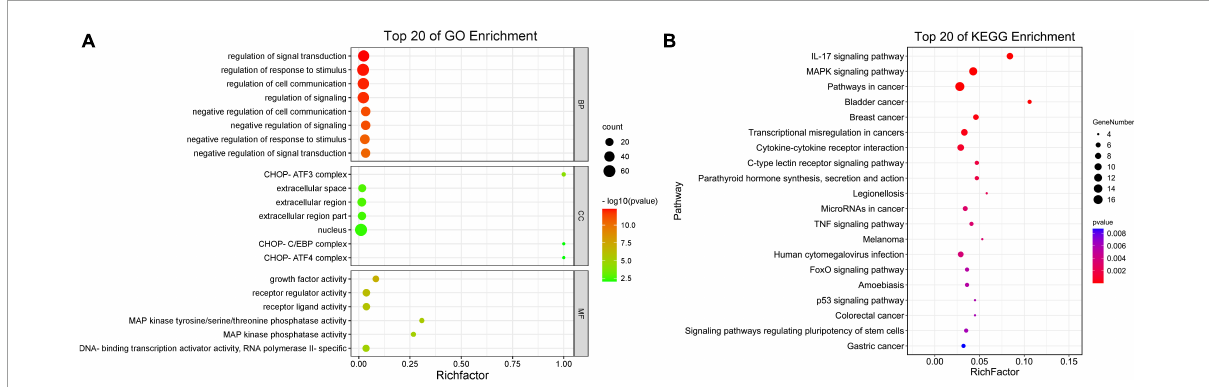
FIGURE3 Scatter plot of enriched GO terms and KEGG pathway statistics. Rich factor is the ratio of the differentially expressed gene number to the total gene number in a certain pathway. The color and size of the dots represent the range of the –log10( p -value) and the number of DEGs mapped to the indicated terms, respectively. The top 20 enriched GO terms (A) and KEGG pathways (B) are shown in the figure.